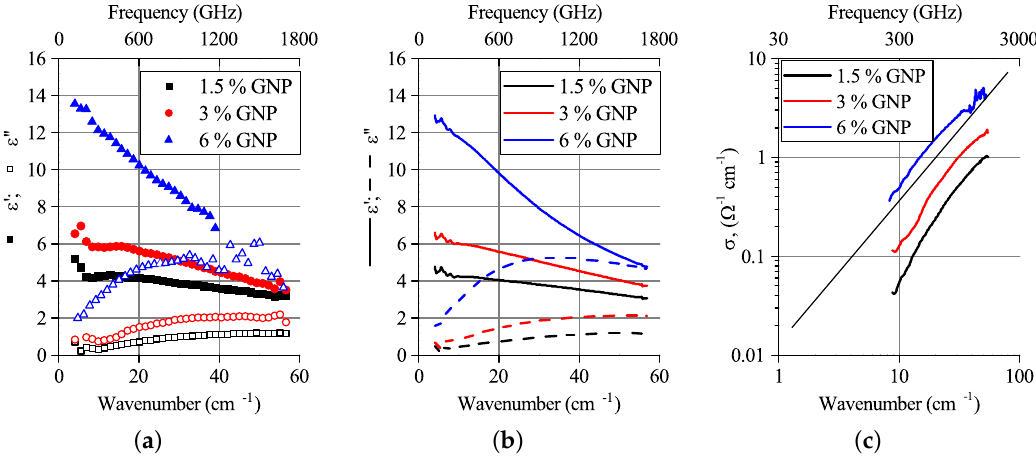
Figure 5. ( a ) Complex permittivity of composites containing 1.5, 3 and 6 wt.% GNP; ( b ) Maxwell Garnett approximation of the experiment with the following fitting parameters: σ = 20,000 S/m, and AR ∼ 197, 208 and 291, respectively; ( c ) conductivity values of GNP-based composites having similar